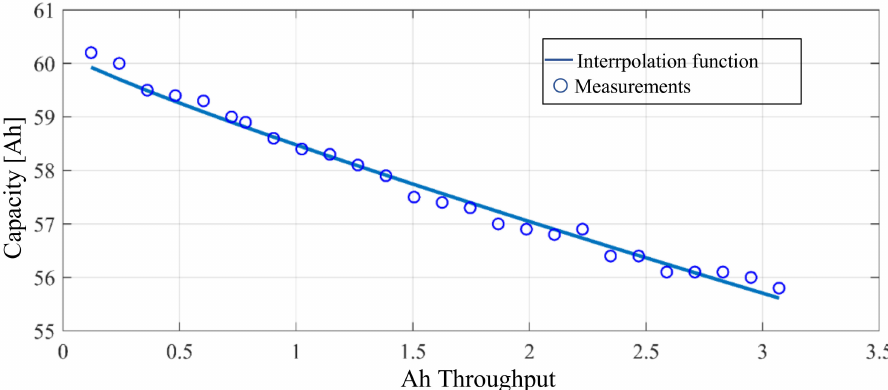
Figure 8. Comparison between the capacity interpolation function and the experimental measurements.